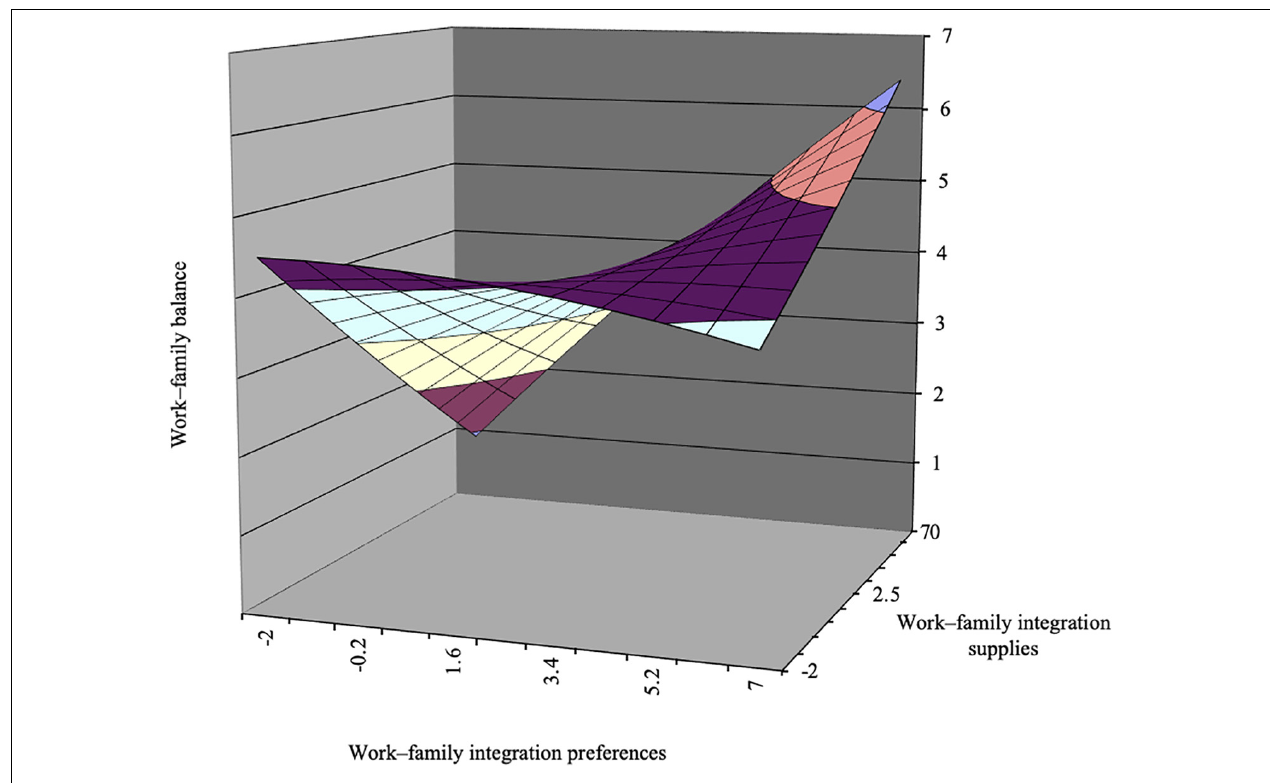
FIGURE 1 | Congruence effect and asymmetrical incongruence effect of personal preferences for work–family integration and organizational supplies in work–family integration on work–family balance